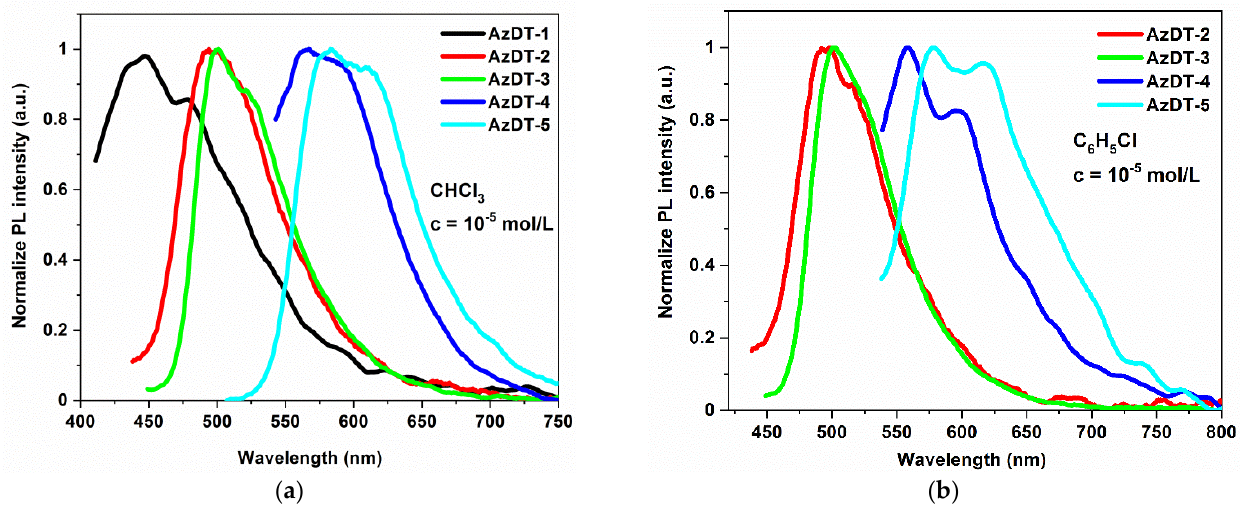
Figure 5. The emission spectra (PL) ( a ) in chloroform and ( b ) in chlorobenzene solution ( λ ex taken from the UV-Vis spectra, presented inTable 3).